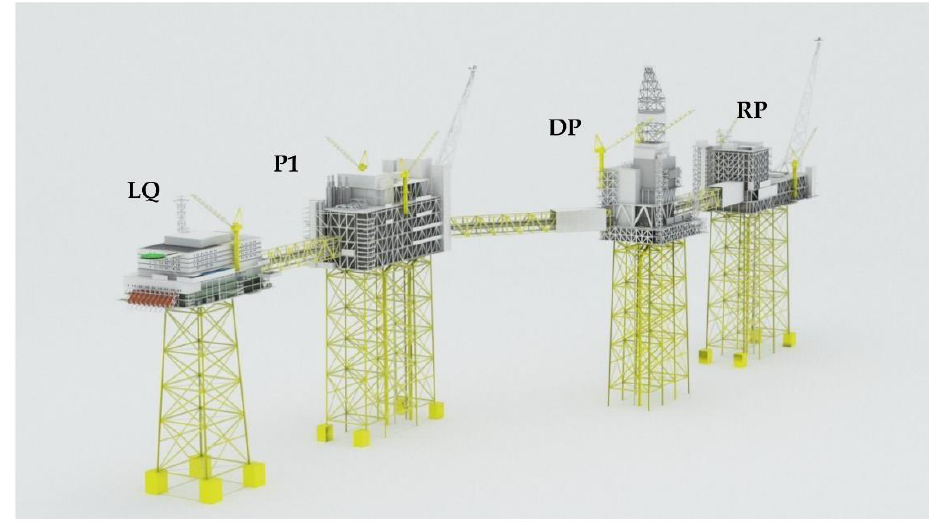
Figure 1. The arrangement system of the central section of the Johan Sverdrup field.